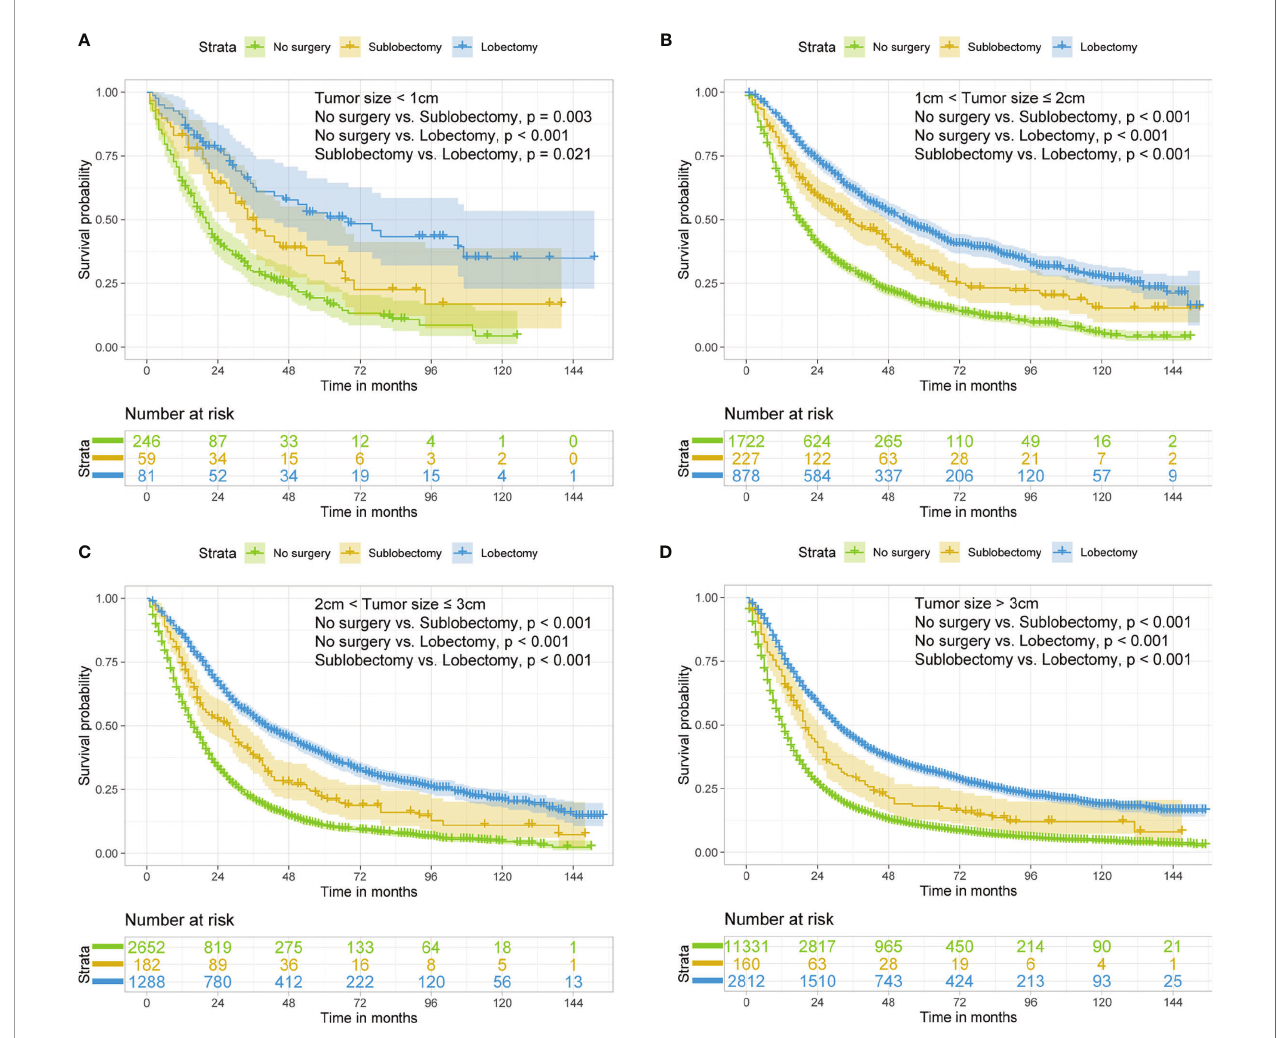
FIGURE 3 | Kaplan – Meier estimates of OS for stage IIIA/N2 NSCLC patients with tumor size <1 cm (A) , 1 cm < tumor size ≤ 2 cm (B) , 2 cm < tumor size ≤ 3 cm (C) , tumor size >3 cm (D) strati fi ed by surgery strategy. OS, overall survival; NSCLC, non-small cell lung